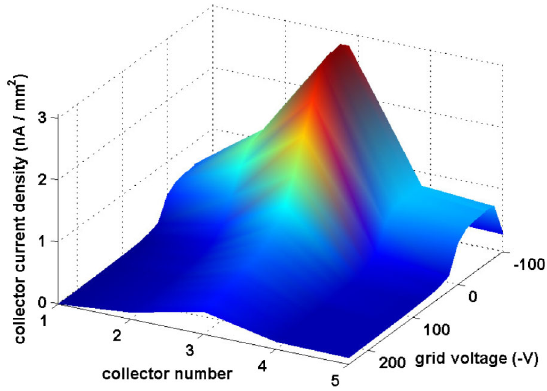
FIG. 2. RFA voltage scan in a Cu chamber, 1 × 45 × 1 . 25 mA e þ , 14 ns, 5.3